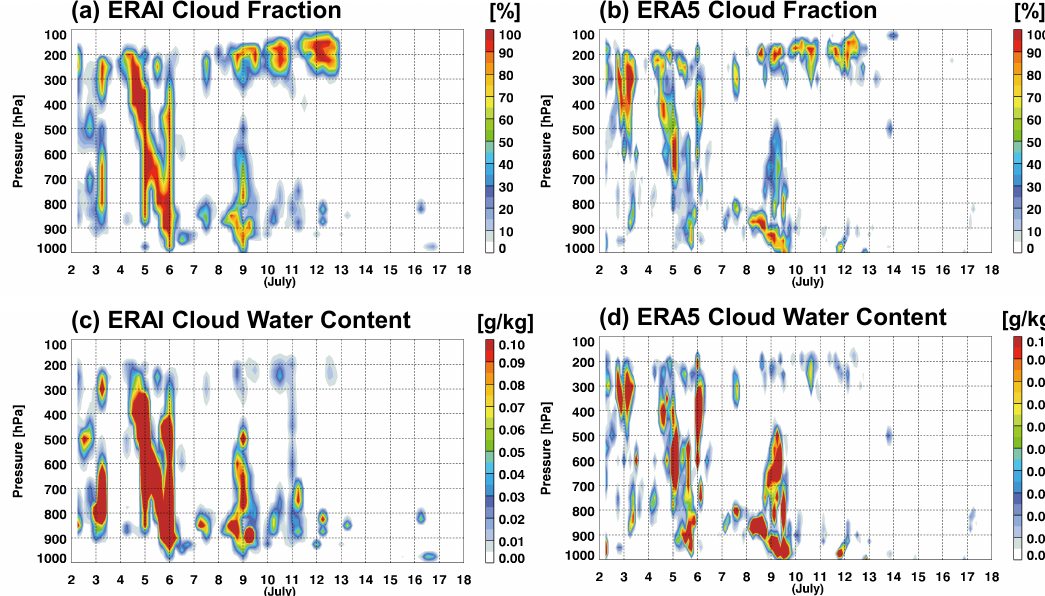
Figure 5. Time series of profiles of cloud fraction and cloud (liquid + ice) water content (bottom) for ERAI and ERA5 datasets at the Boseong station in July 2018: ( a ) Cloud fraction for ERAI dataset; ( b ) cloud fraction for ERA5 dataset; ( c ) cloud water content for ERAI dataset; ( d ) cloud water content for ERA5 dataset.